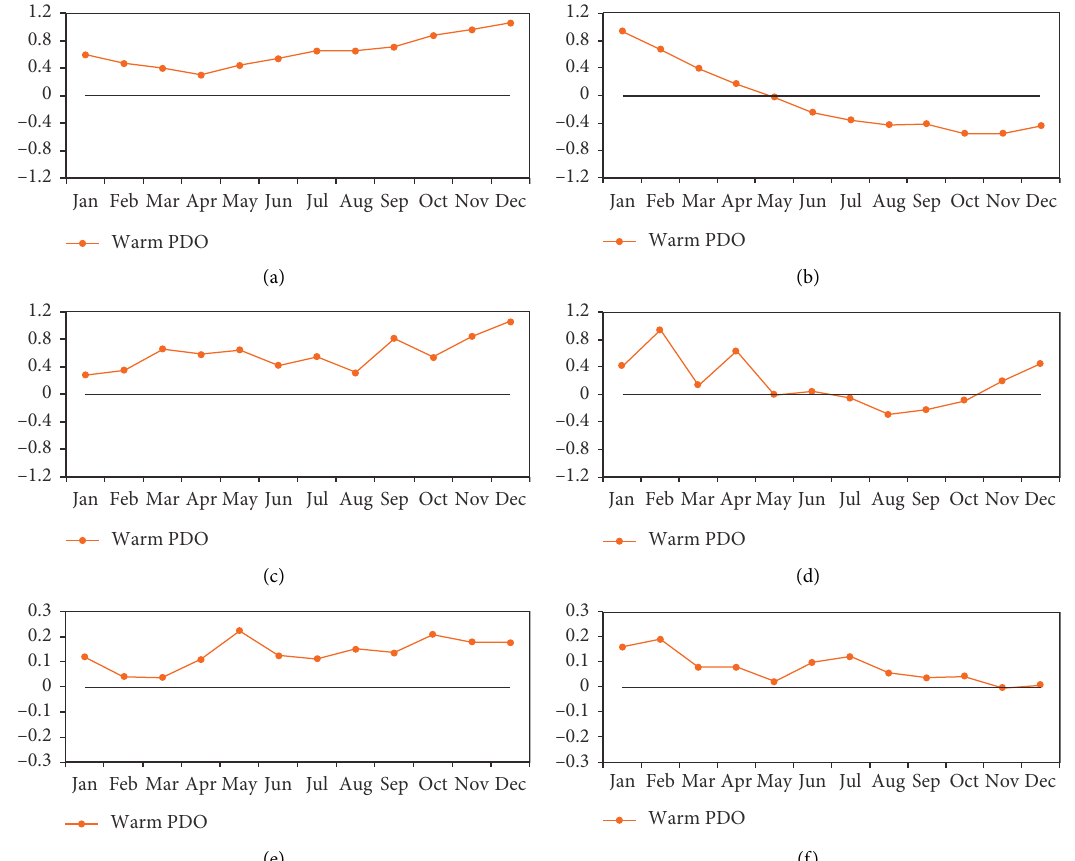
Figure 9: Same as Figure 8 but for the warm PDO phase. (a) Developing period, central-eastern Pacific SST. (b) Decaying period, central- eastern Pacific SST. (c) Developing period, zonal wind. (d) Decaying period, zonal wind. (e) Developing period, north Indian Ocean SST. (f) Decaying period, north Indian Ocean